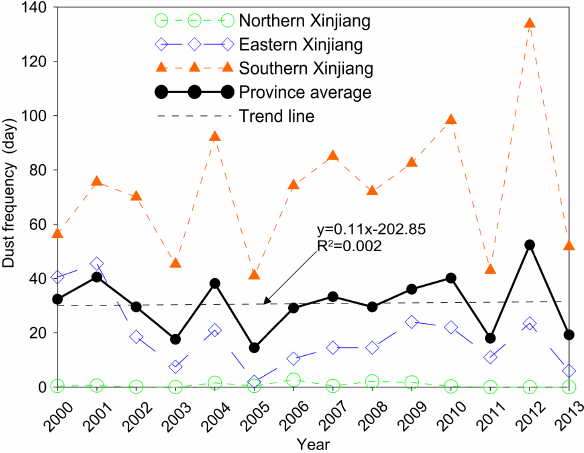
Figure 9. Dust day frequency in Xinjiang Province from 2000 to